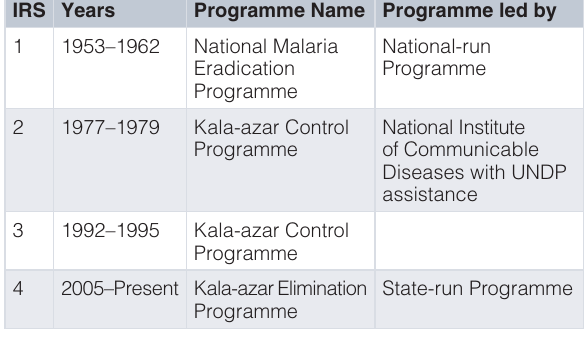
(Table 4). Overall, average VL case incidence, irrespective of time period, was lower (2.172–3.133) during years of higher rainfall (Above Normal or Excess to the LPA).